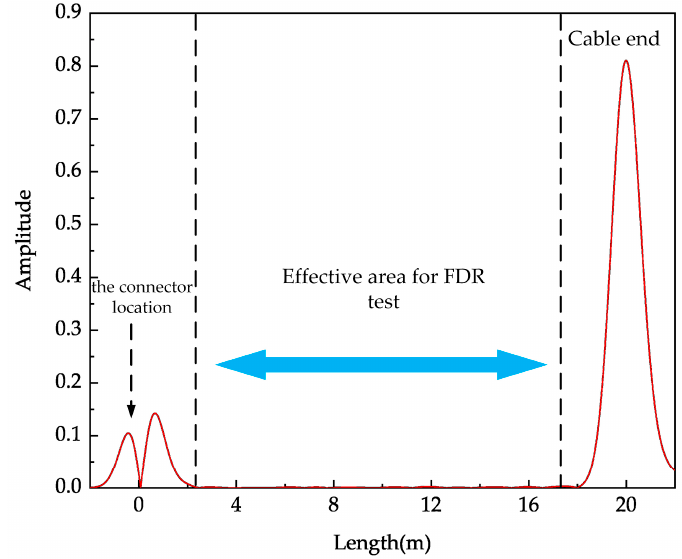
Figure 11. Location result of the tested cable.